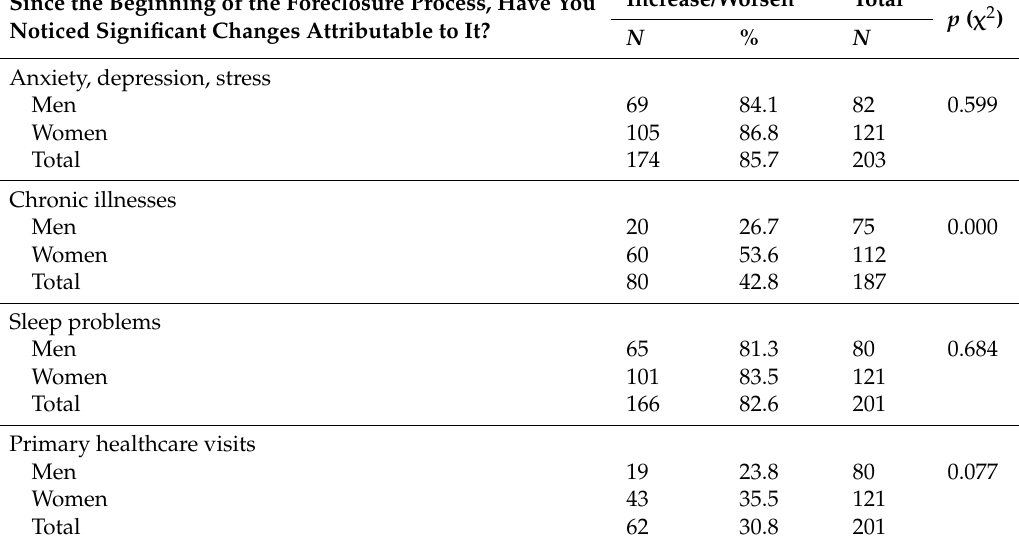
Table 2. General perception of changes in health, use of health services, consumption of medication and health-related habits, attributable to foreclosure, by